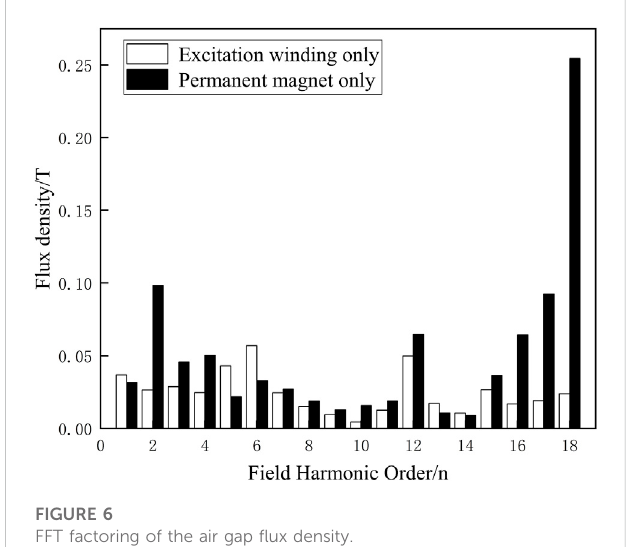
FIGURE 7 Effect of secondary pole arc coef fi cient on thrust.